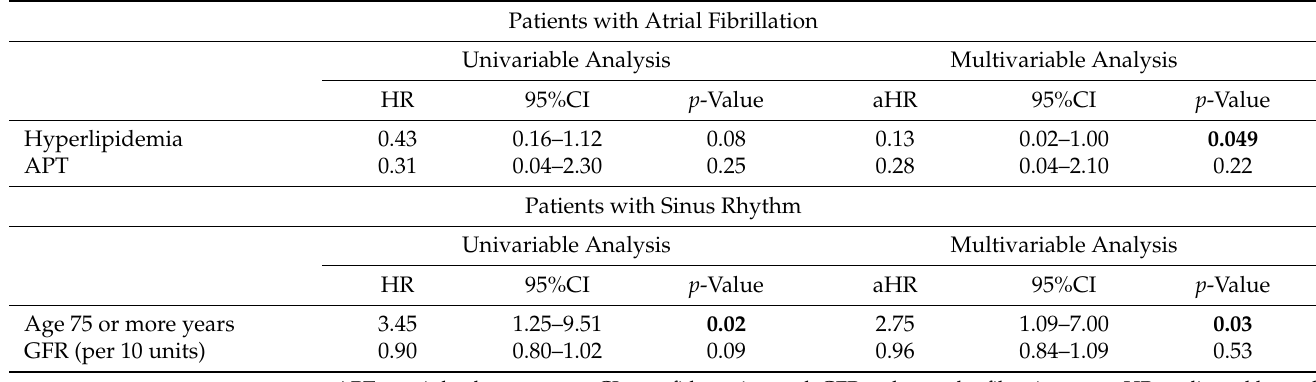
Table 5. Univariable and multivariable logistic regression analysis—factors predisposing one to cardiovascular mortality in the group of patients with atrial fibrillation and sinus rhythm. Patients with Atrial Fibrillation Univariable Analysis Multivariable Analysis